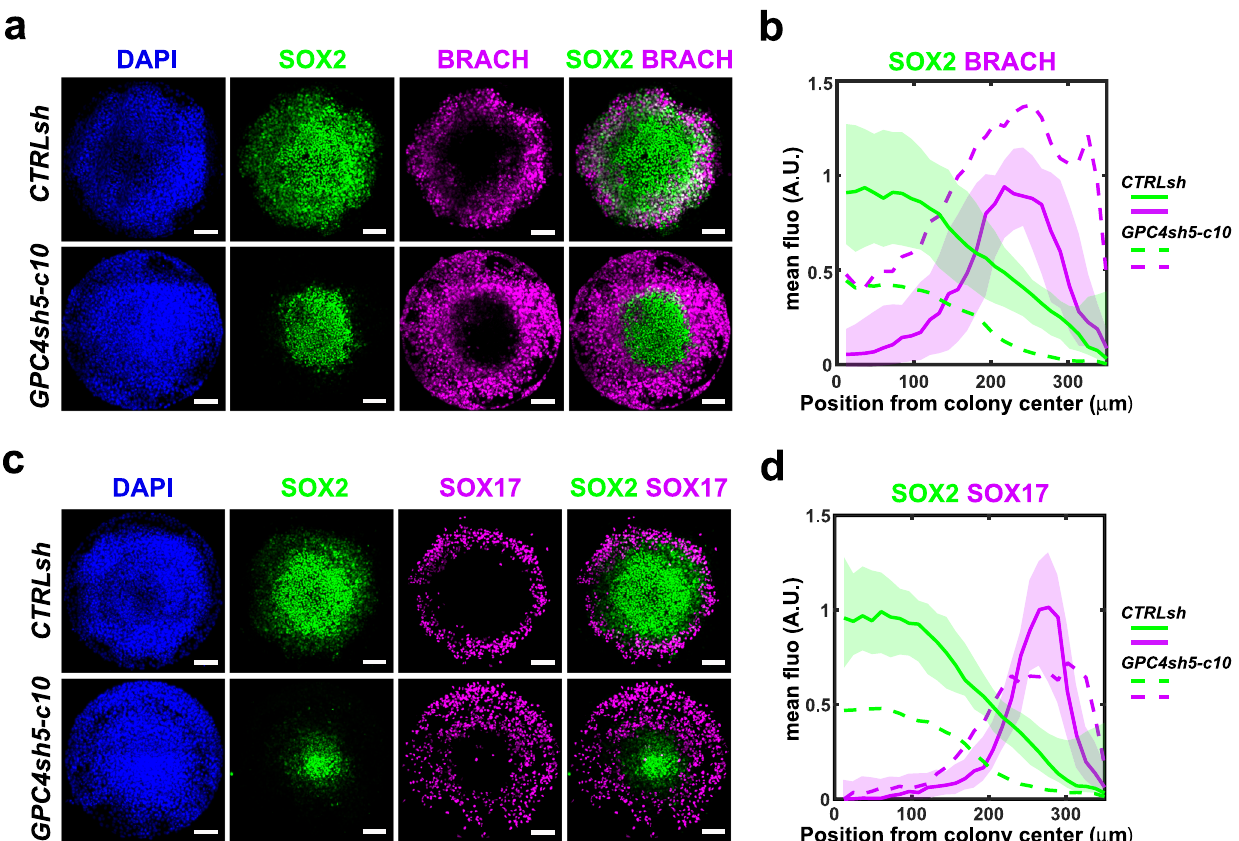
Fig. 4 | GPC4 downregulation impacts lineage repartition in 2D gastruloids. a Representative 2D gastruloids immunostained for DAPI positive nuclei (blue), SOX2(green)andBRACH(magenta)proteins48hafterthestartofBMP4stimulation (colony diameter 700 μ m; scale bar 100 μ m). b Quanti fi cation of SOX2 and BRACH radialpro fi lesofexpressioninhuman2Dgastruloidsofpanel a .Foreachstain,radial pro fi les are normalized by the maximum of the control pro fi le. Shaded areas represent the 1st and 3rd quartiles of the individual colony pro fi les with a line at the mean. CTRLsh: n =64, GPC4sh n =67 colonies from three biological replicates.